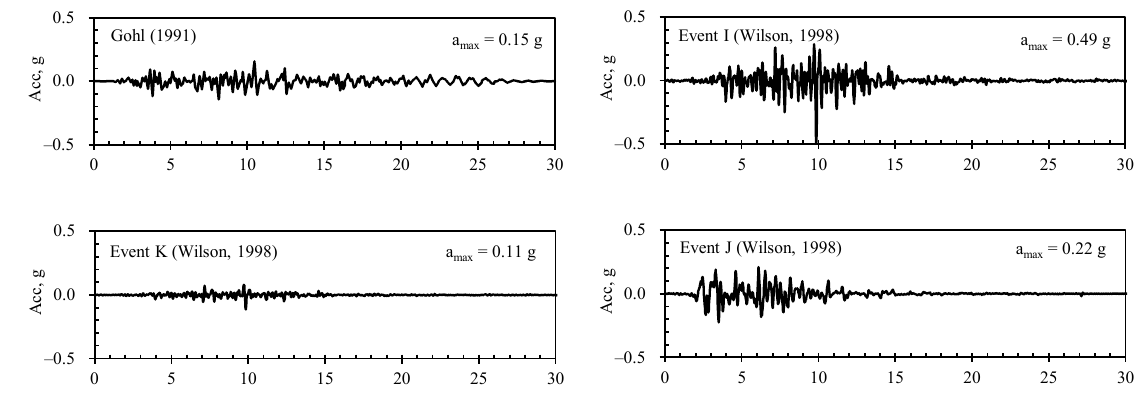
Figure 6. Earthquake records used in the centrifuge tests of Gohl [30] and Wilson [31].